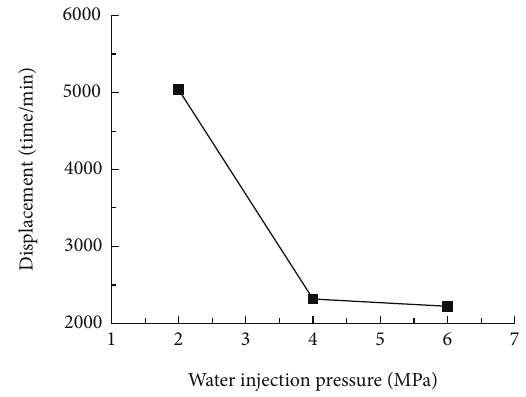
Figure 7: Displacement time under di ff erent water injection